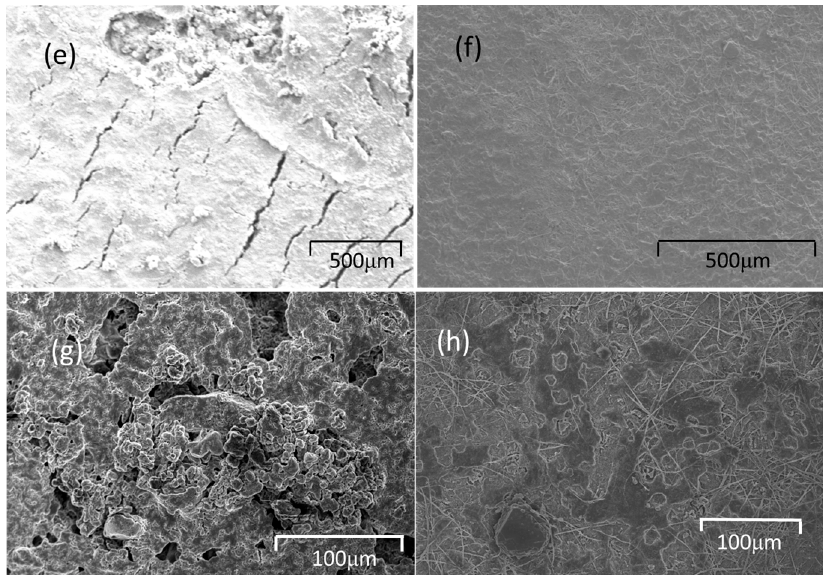
Figure 9. SEM images of the anode with and without interlayer after cycles at 0.1 C ( a – d ); the anode without interlayer after 100 cycles at 0.1 C ( a , c ); the anode with interlayer after 100 cycles at 0.1 C ( b , d ); SEM images of the anode with and without interlayer after cycles at 1 C ( e – h ); the anode without interlayer after 600 cycles at 1 C ( e , g ); the anode with interlayer after 600 cycles at 1 C ( f , h ).